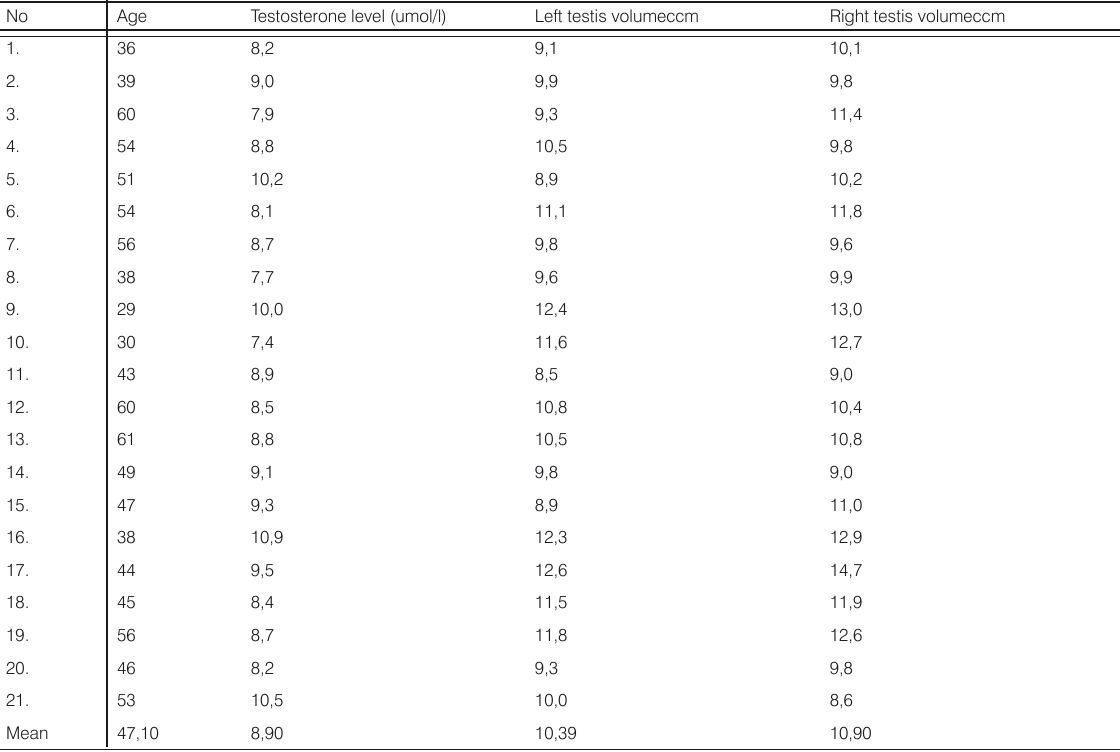
Table 1. Total testosterone serum levels and volume of testes in patients with compensated alcoholic cirrhosis.